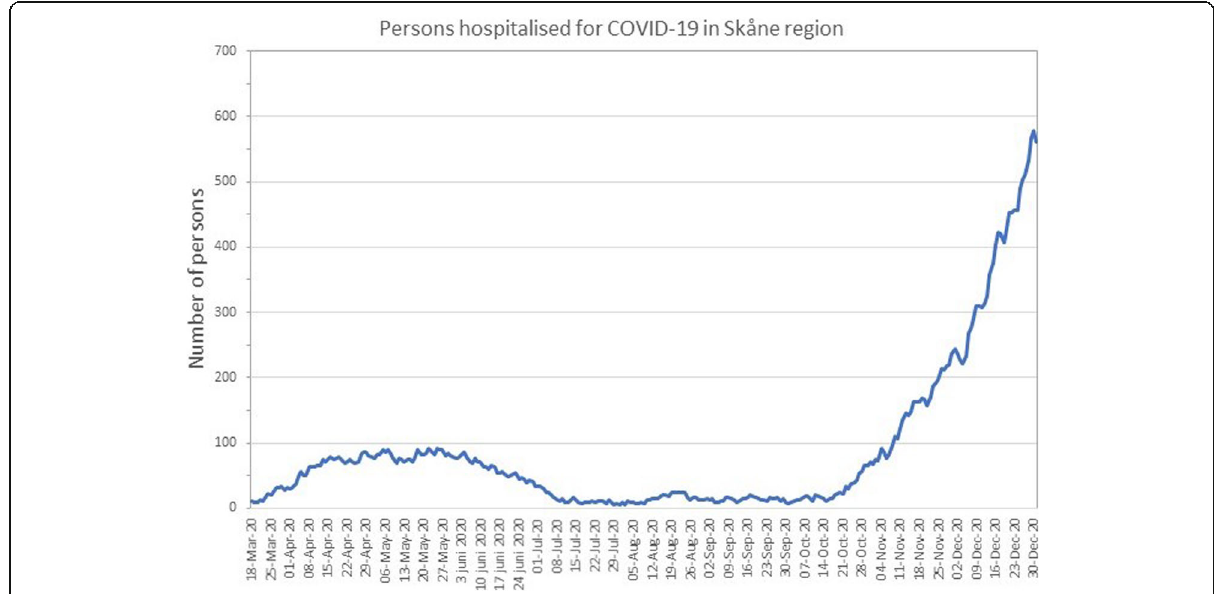
Fig. 1 Number of persons hospitalised for COVID-19 per week in the Skåne region. Official Skåne region data retrieved on 19/03/2021 from: